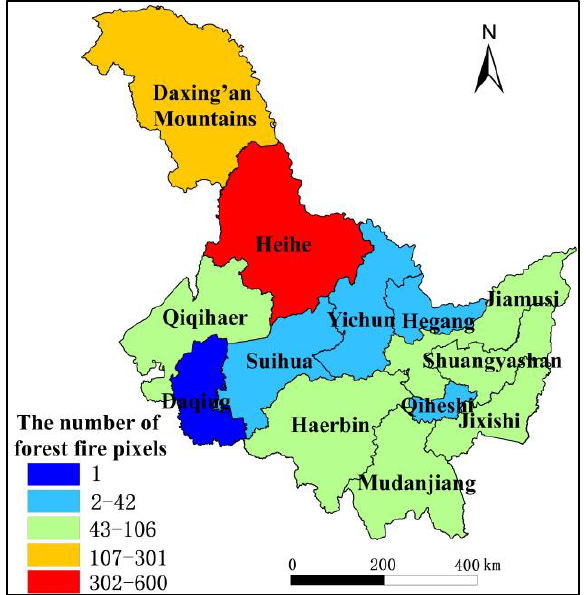
Figure 3. Distribution of cumulative number of forest fires monitored by VIIRS in the jurisdiction of Heilongjiang Province, 2013–2020.